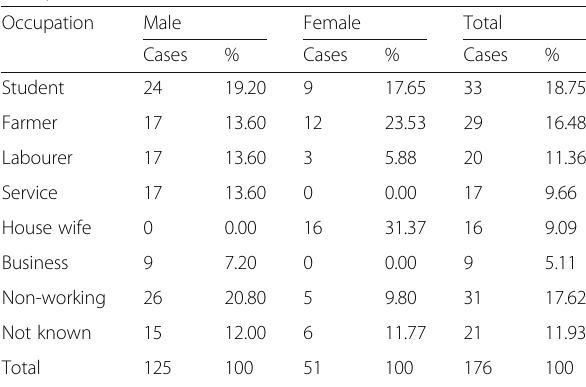
Table 2 Distribution of drowning deaths according to